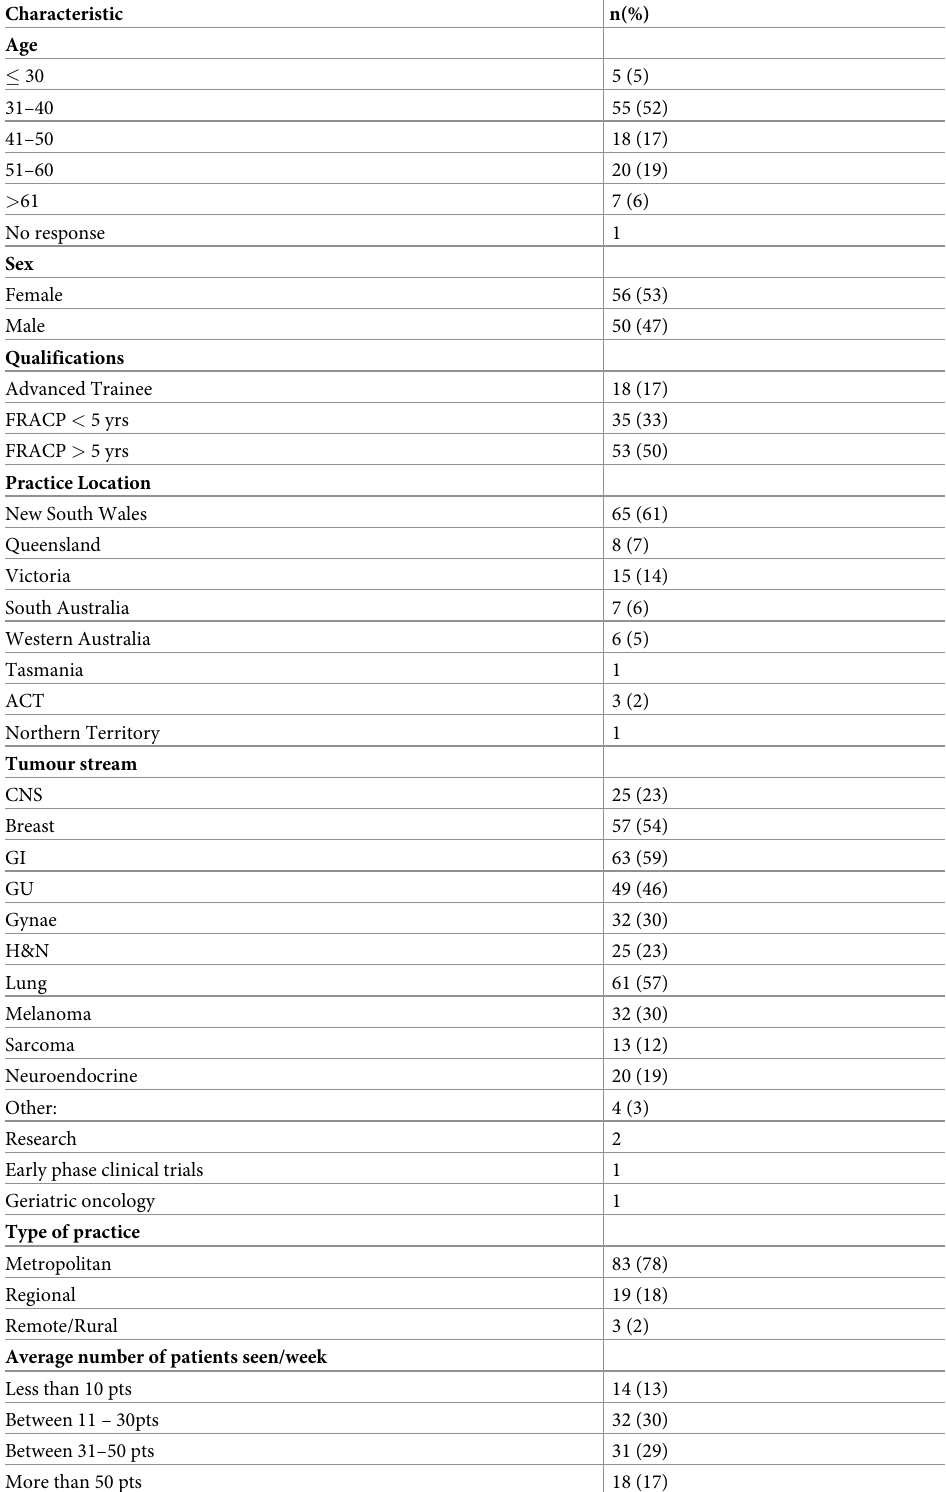
Table 1. Personal and professional characteristics of 106 responding